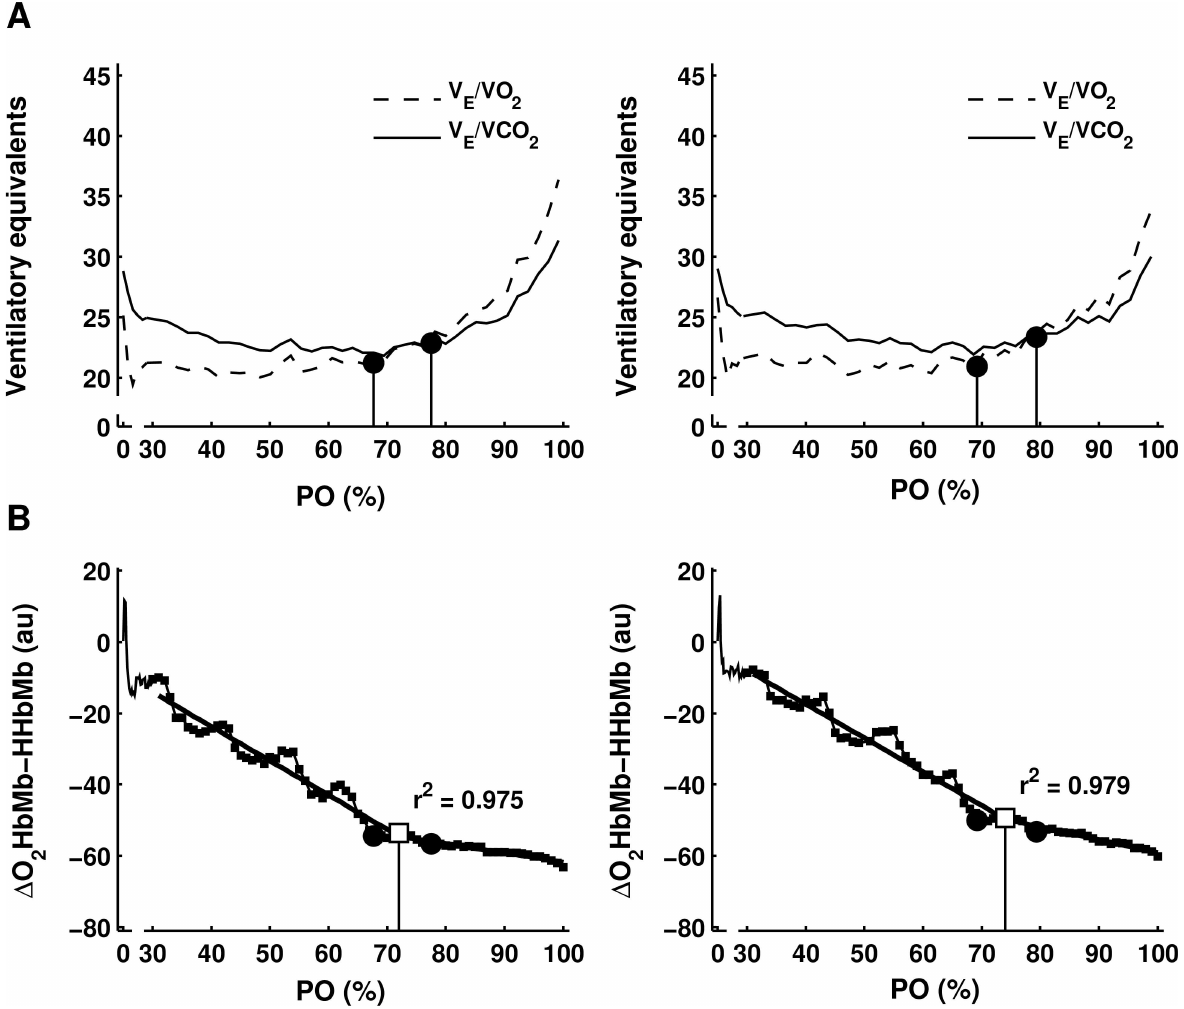
Fig 1. Typical exampleof detectionof Δ [O 2 HbMb-HHbMb]-BPand ventilatory thresholds. Ventilatory thresholdsVT1 and VT2 (closedcircles)are depictedwithin the ventilatoryequivalent versus PO graph (uppergraphs, a). Δ [O 2 HbMb-HHbMb]-BP(opensquare) is derived from Δ ([O 2 HbMb]–[HHbMb])versus PO graph by means of double linearregressionanalyses with the least combinedresidual sum of squares(lower graphs, b). Both Δ [O 2 HbMb-HHbMb]-BP and ventilatorythresholdsare determined for subsequent trialsin a trainedmale cyclist for test (leftgraphs)and